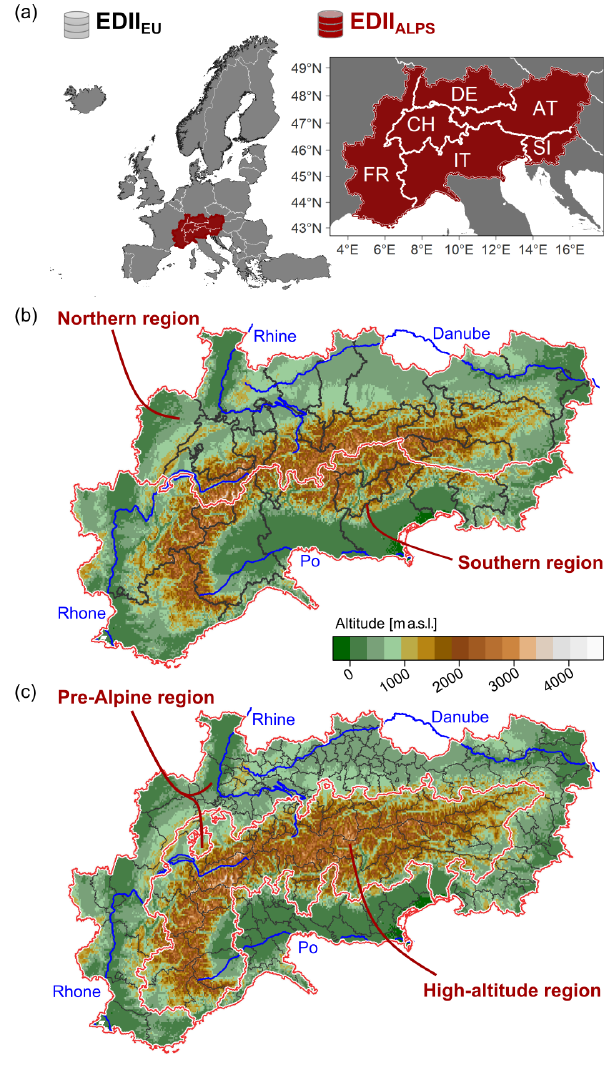
Figure 1. (a) The EDII EU coverage of the whole of Europe as in Stahl et al. (2016), integrating the area covered by the newly up- dated Alpine Drought Impact report Inventory (EDII ALPS ). The EDII ALPS paired domains for the analysis are (b) the northern re- gion and southern region divided by grouped NUTS 2 regions, and (c) the pre-Alpine region and high-altitude region divided by grouped NUTS 3